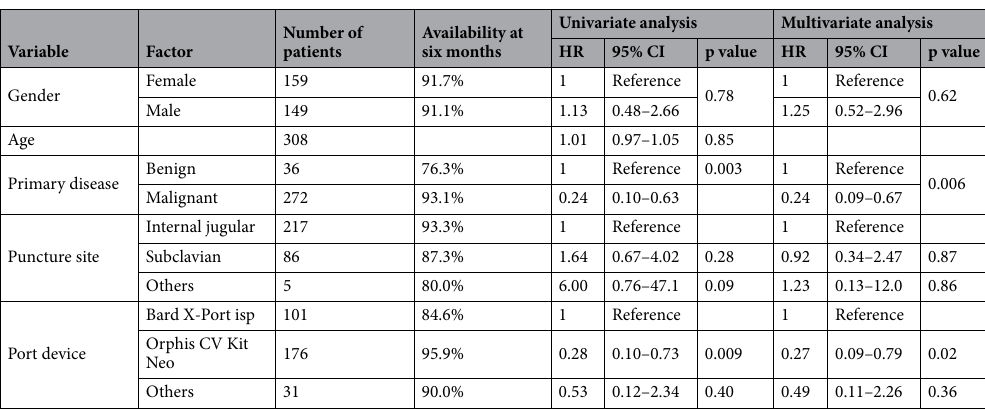
Table 5. Univariate and multivariate analyses of long-term availability of CVP. HR hazard ratio, CI confidence